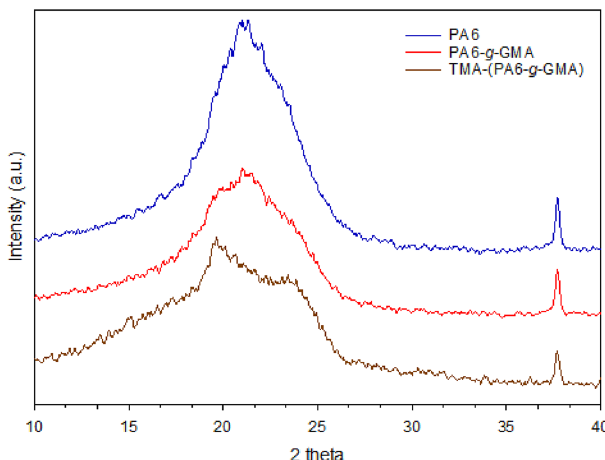
Figure 4. XRD patterns of original PA6, PA6- g -GMA and TMA-(PA6- g